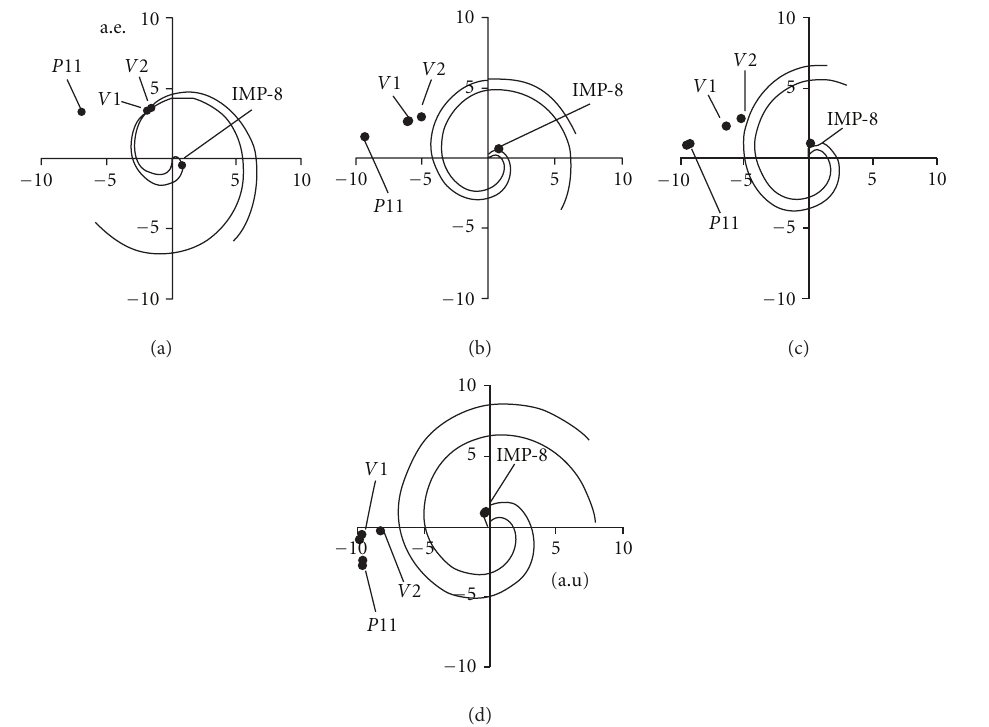
Figure 17: Spatial structures, bordered by spirals of IMF and comprising decreased fluxes of low-energy protons (Ep ∼ 1MeV), projected onto the ecliptic plane. Time periods from left to right: August 22–September 04, 1978; October 29–November 09, 1979; December 06–23, 1979; January 05–23, 1981. The spirals were calculated from solar wind velocities measured on IMP-8 at the beginning and at the end of intervals with “caverns”—intervals with low fluxes of